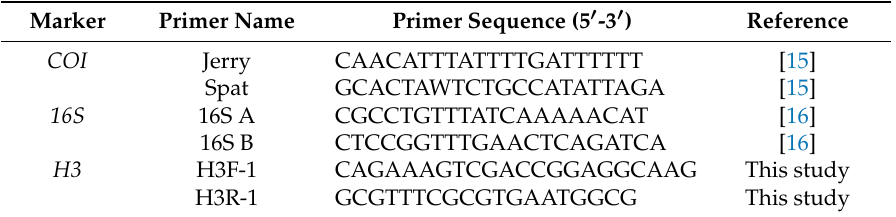
Table 2. Information on the primer sequences and corresponding genes